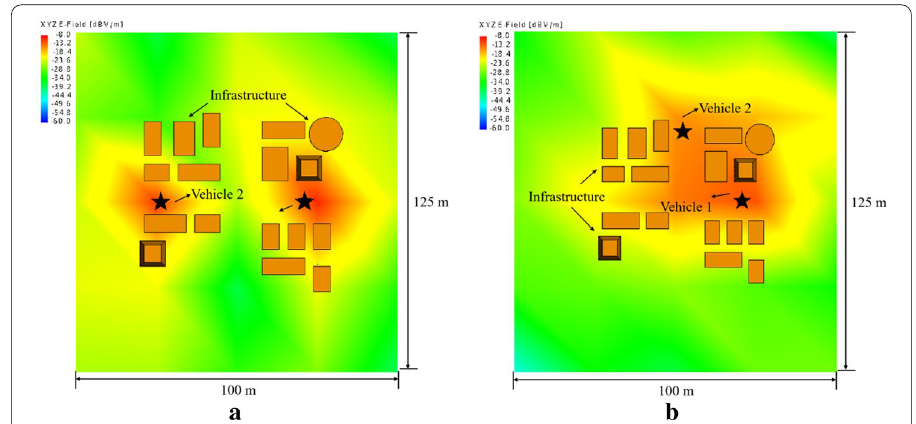
Fig. 15 Distribution of electrical field for two automobile antennas in the urban environment. a LOS environment. b NLOS